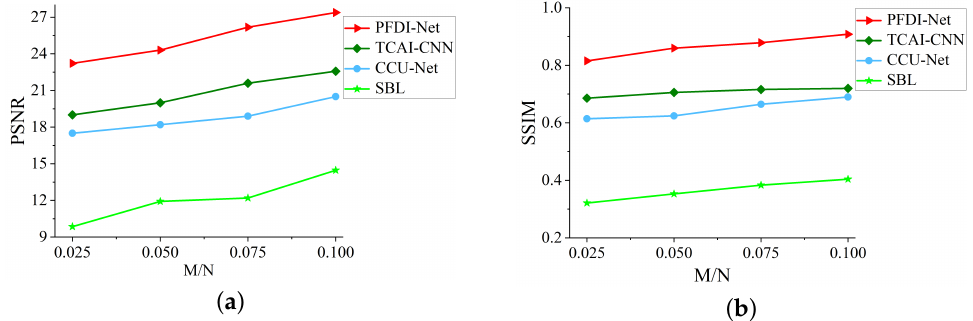
Figure 8. PFDI-FMNIST: Imaging results in two imaging algorithm with different scene information sampling ratio. ( a ) PSNR performance. ( b ) SSIM